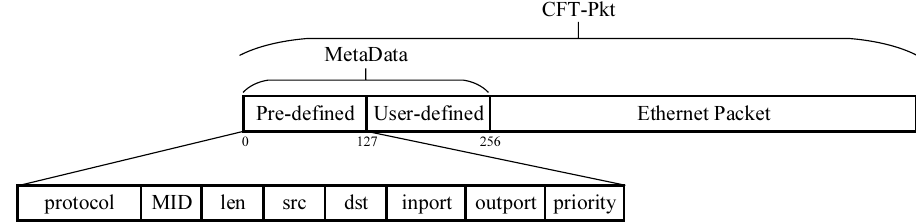
Figure 8. The format of the MetaData and fields in pre-defined